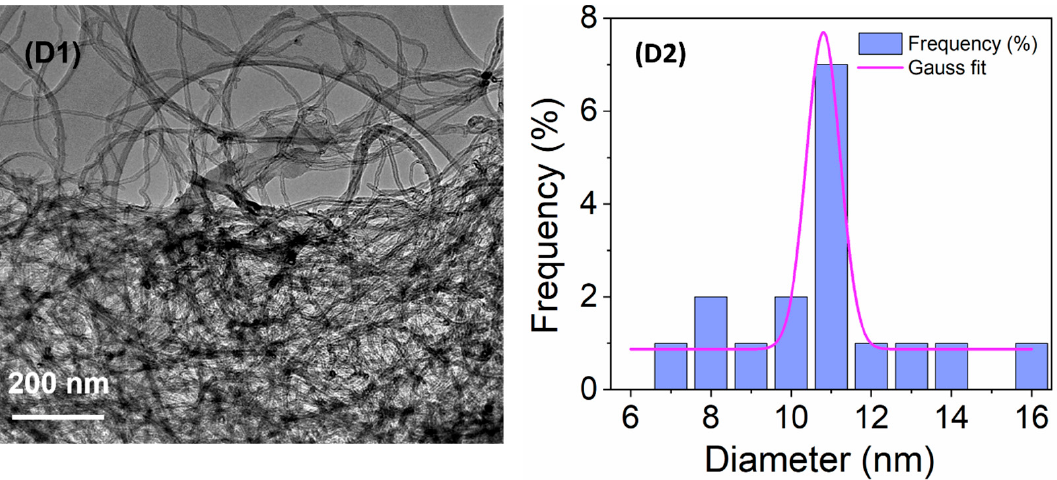
Figure 1. TEM micrographs and corresponding particle size distribution ( A1 , A2 ) SiO 2 NPs, ( B1 , B2 ) fSiO 2 NPs, ( C1 , C2 ) CNTs, and ( D1 , D2 ) fCNTs. Table 2. Physical characteristics of the as-synthesised PVDF and PTFE membranes. Membrane Porosity (%) WCA ( ◦